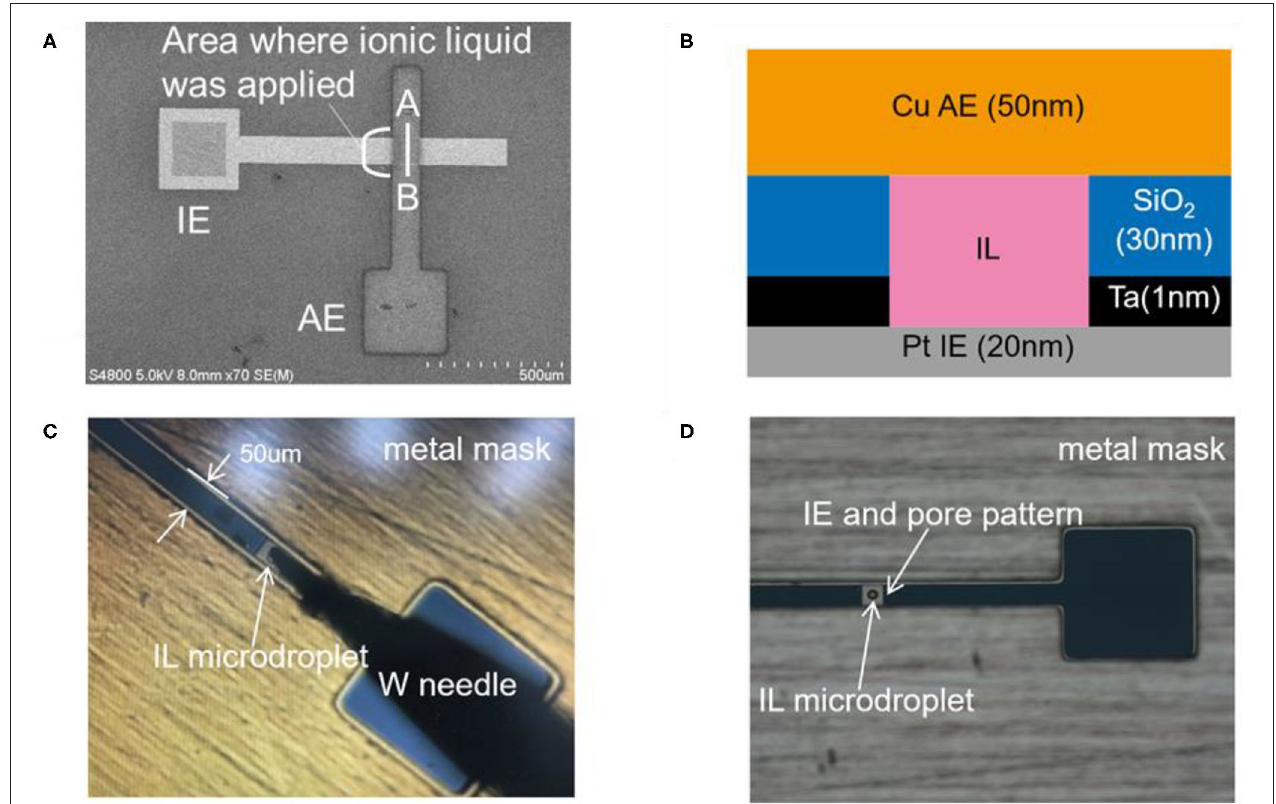
FIGURE 1 | (A) The SEM image of IL-Memristor and (B) the cross-sectional view of IL-Memristor for lines A-B in (A) . Photographs of (C) the W needle used to deliver IL microdroplet and (D) IL microdroplet on the IE and pore pattern. A metal mask for Cu AE pattering is also shown in (C,D) . IL is filled in a pore structure microfabricated in the 30nm thick SiO 2 layer between Cu and Pt electrodes. In IL-Memristor, IL is used as a location for the Cu ion